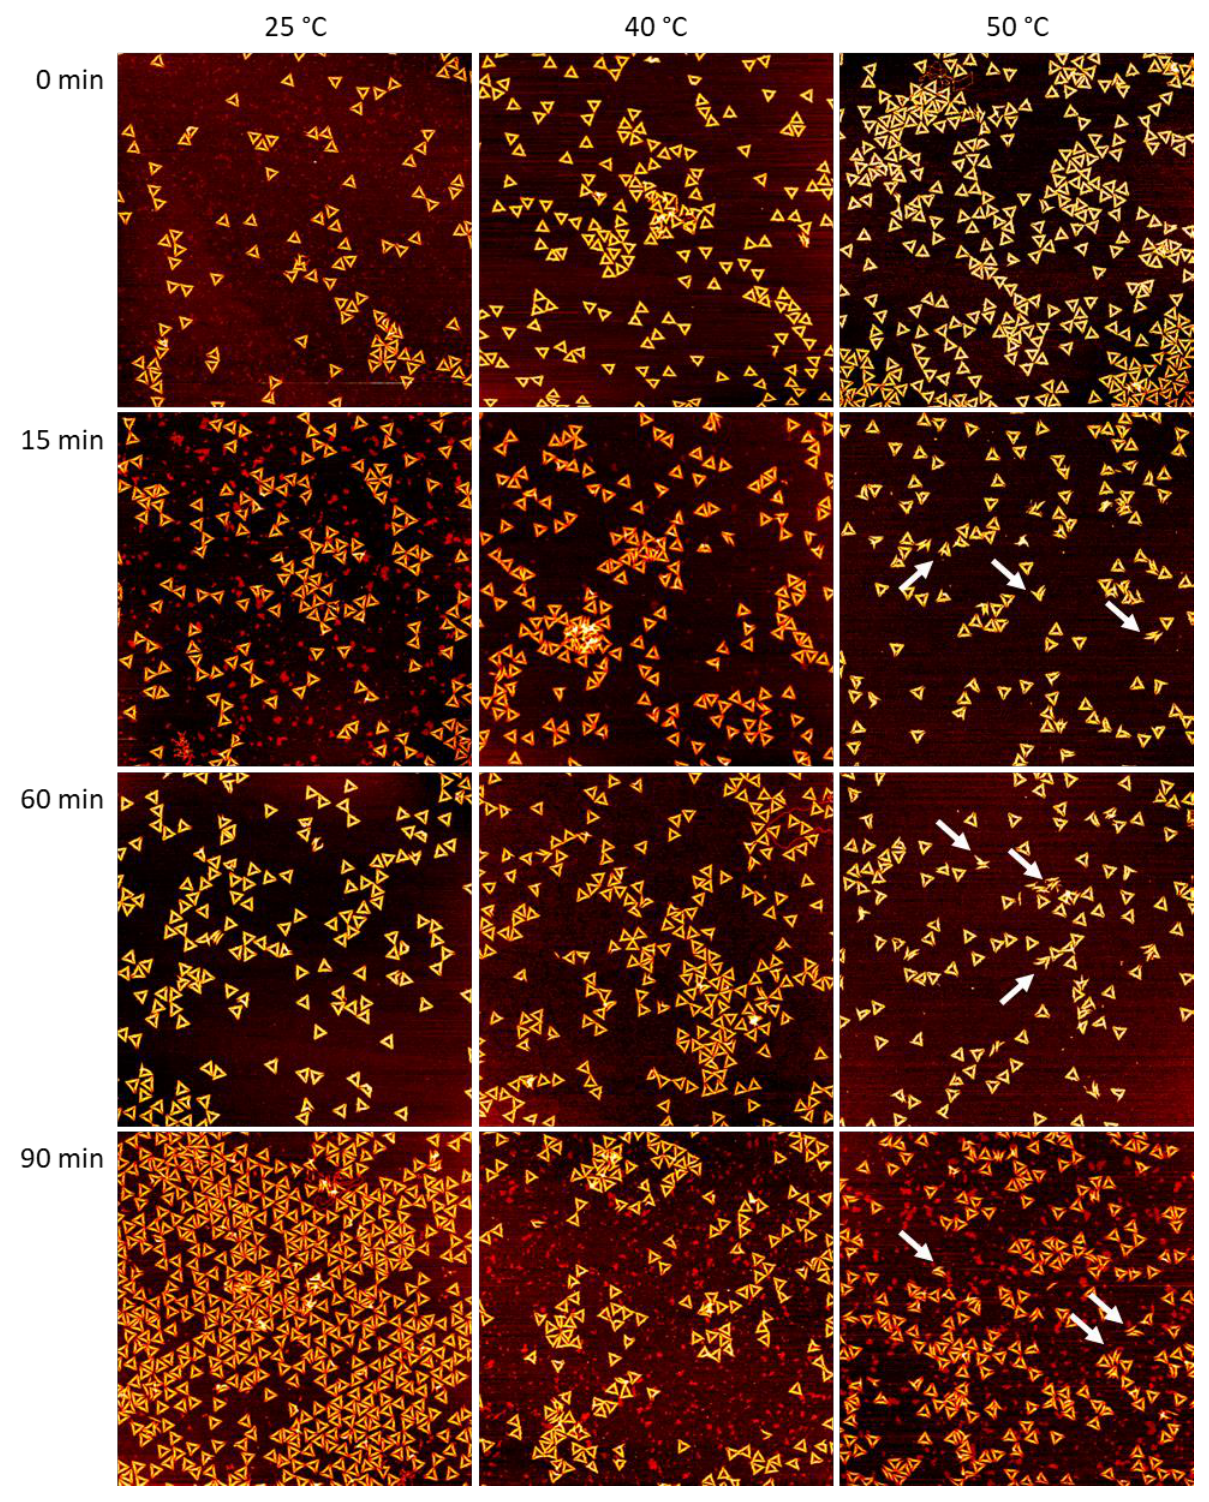
Figure 1. AFM images of DNA origami triangles after incubation in 2 M GdmCl at different times and temperatures. Images have a size and height scale of 3 × 3 µm 2 and 2 nm, respectively. The white arrows indicate collapsed triangles that disintegrated by rupture at the vertices. For additional AFM images, see Figures S1 – S3.